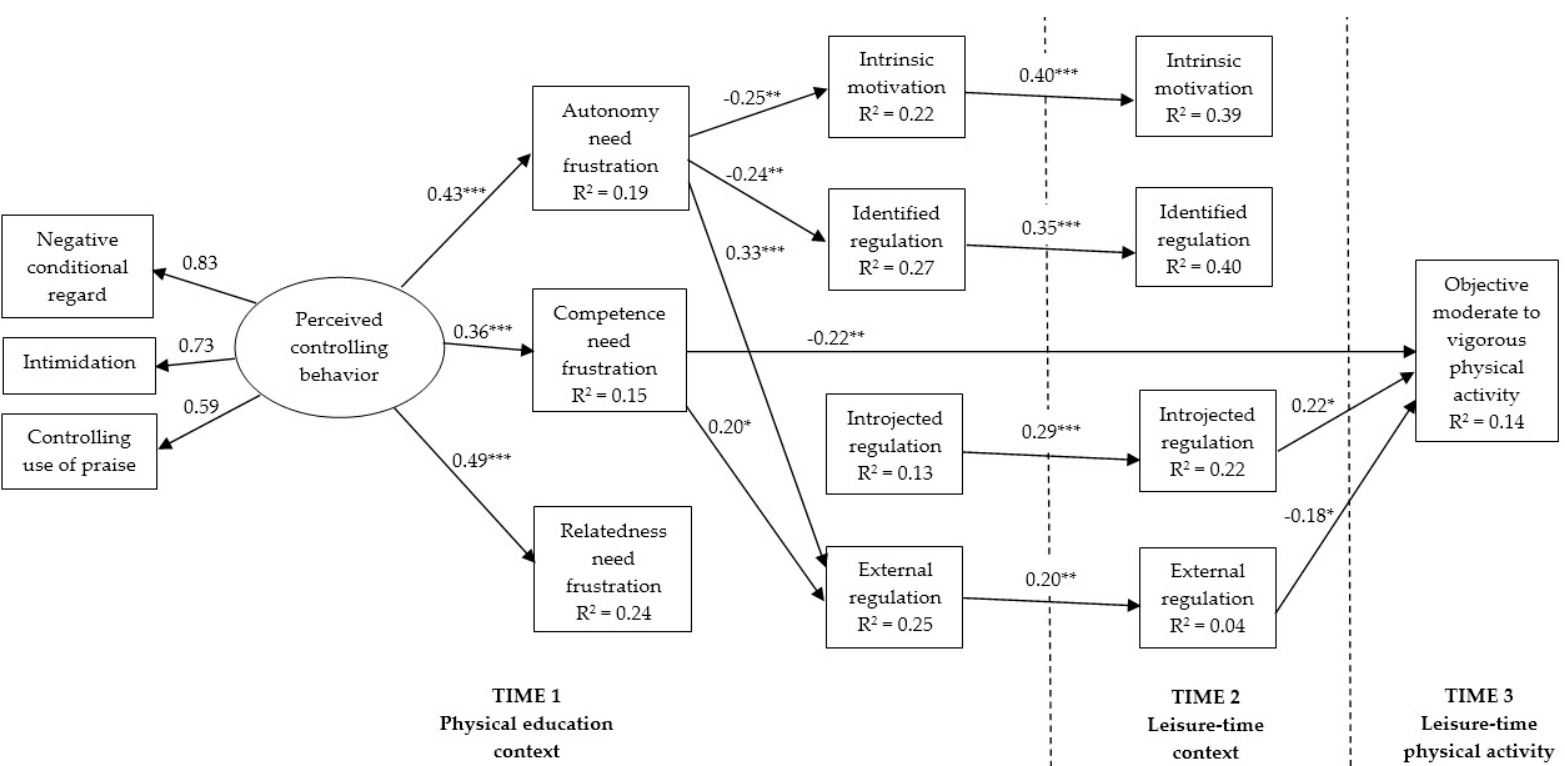
Figure 2. Objectively measured leisure-time moderate-to-vigorous physical activity in adolescents predicted by teachers’ perceived controlling behavior and basic psychological needs frustration in PE, and different motivational regulations in PE and leisure-time context. For clarity, only significant paths are presented. In addition, the effects of past physical activity behavior on endogenous variables and error covariances among need frustration variables as well as different motivational regulation variables in both PE and leisure-time contexts are not depicted. Past physical activity behavior exerted significant direct relationships with competence need frustration ( − 0.17 *), intrinsic motivation in PE (0.31 ***), identified regulation in PE (0.37 ***), introjected regulation in PE (0.33 ***), intrinsic motivation in leisure-time (0.36 ***), identified regulation in leisure-time (0.41 ***), and introjected regulation in leisure-time (0.29 ***). * p < 0.05, ** p < 0.01, *** p < 0.001.